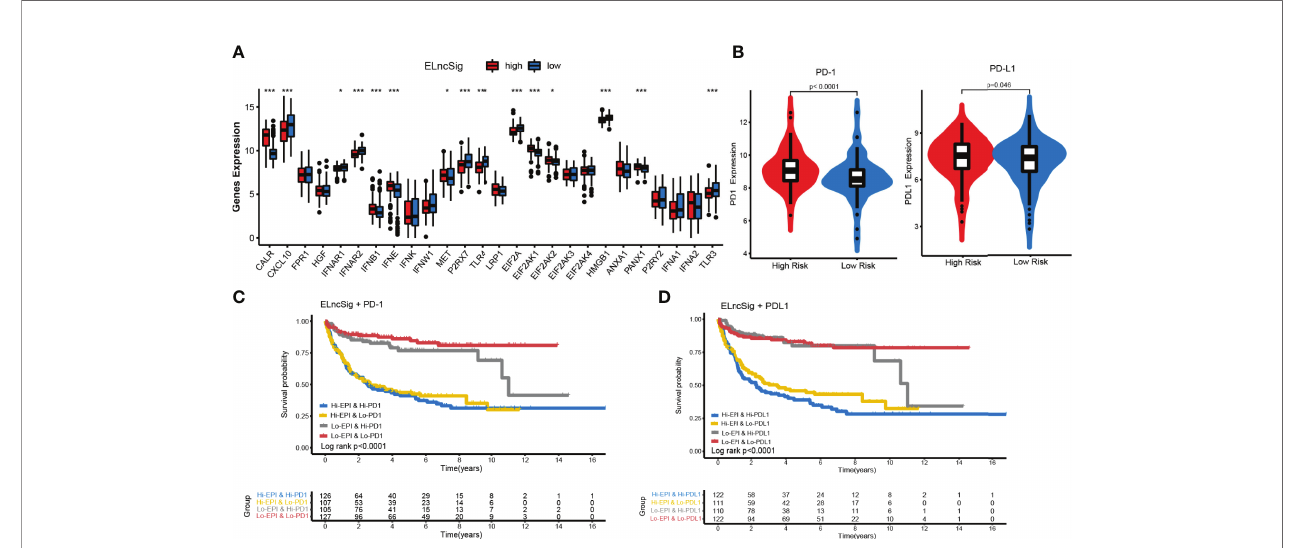
FIGURE 6 | Impact of immunogenic cell death (ICD) modulators and immune checkpoint gene expression on clinical outcome. (A) Differential expression of ICD modulators between the high- and low-risk ELncSig groups. (B) Immune checkpoint expression of PD-1 and PD-L1. (C, D) Kaplan – Meier survival curves of overall survival among the four patient groups strati fi ed by ELncSig and PD-1 and PD-L1. *p < 0.05, **p < 0.01, ***p < 0.001.